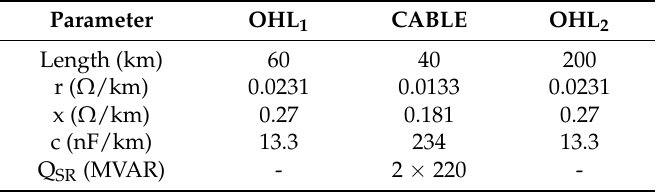
Table A5. Parameters of mixed overhead-cable transmission line.